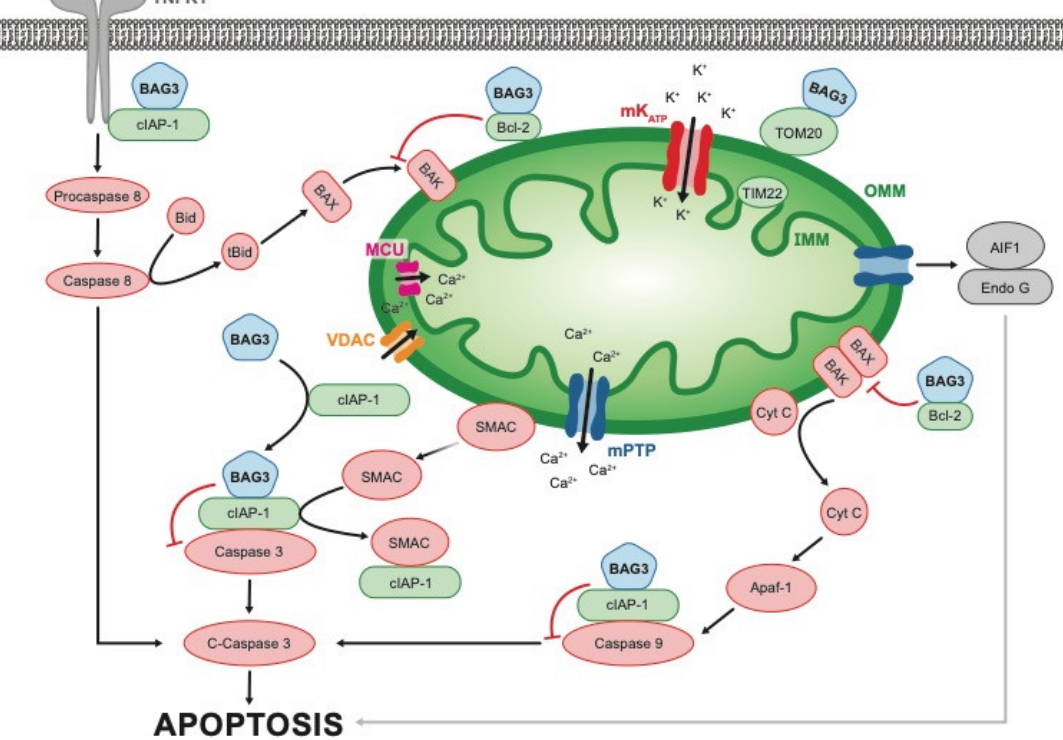
Figure 3. Canonical and non-canonical pathways for mitochondrial regulation of apoptosis and